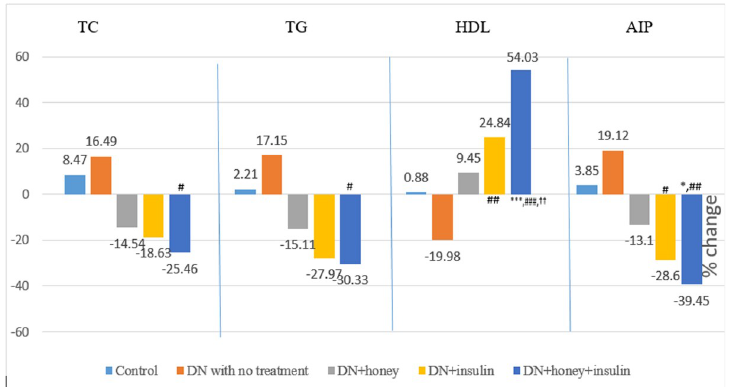
Fig 3. Percentage change in lipid profile before and after six weeks of intervention in all the groups. TC: Total cholesterol; TG: Triglycerides; HDL: High density lipoprotein cholesterol; AIP: Atherogenic index of plasma; P value less than 0.05 were considered statistically significant. � Comparison with normal control group: � (P < 0.05); �� (P < 0.01); ��� (P < 0.001), #Comparison with diabetic neuropathy control group:# (P < 0.05); ## (P < 0.01); ### (P < 0.001), †Comparison with honey treated group: † (P < 0.05); †† (P < 0.01); ††† (P <